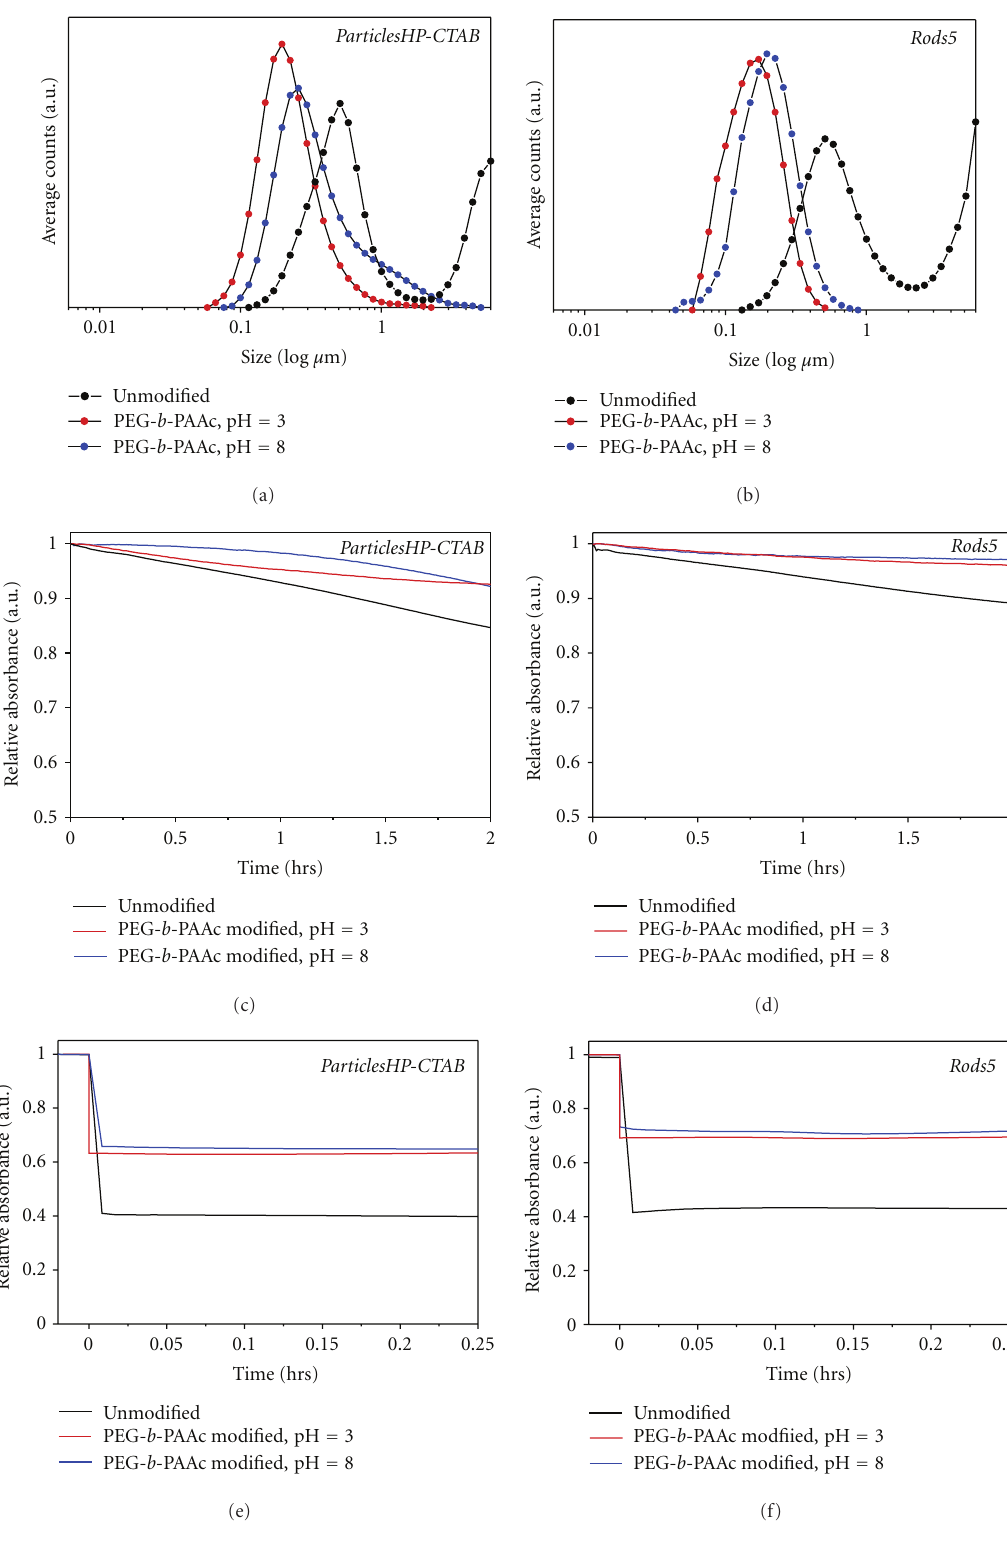
Figure 7: Influence of PEG- b -PAAc modification on (a), (b) the hydrodynamic diameter distribution, (c), (d) dispersion stability of ParticlesHP-CTAB and Rods5 in pure water and (e), (f) at increased solution ionic strength (0.1M